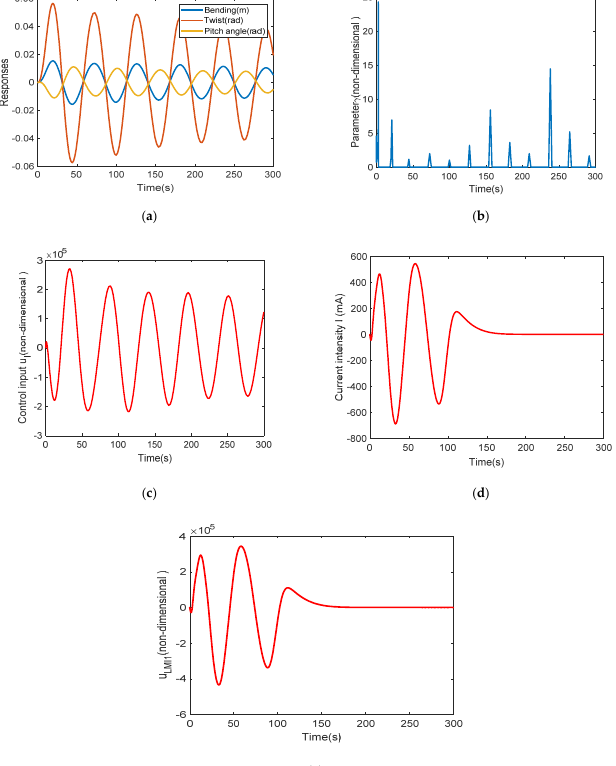
Figure 3. The controlled results and control performance under condition of w = sin ( 0.1 t ) / ( t + 1 ) : ( a ) the controlled bending ( Z ) / twist ( α ) displacements as well as pitch angle β ; ( b ) the robust performance parameters γ ; ( c ) the control input signal u I ; ( d ) the driving current signal I of PFV valve; ( e ) the tracking signal u LMI .